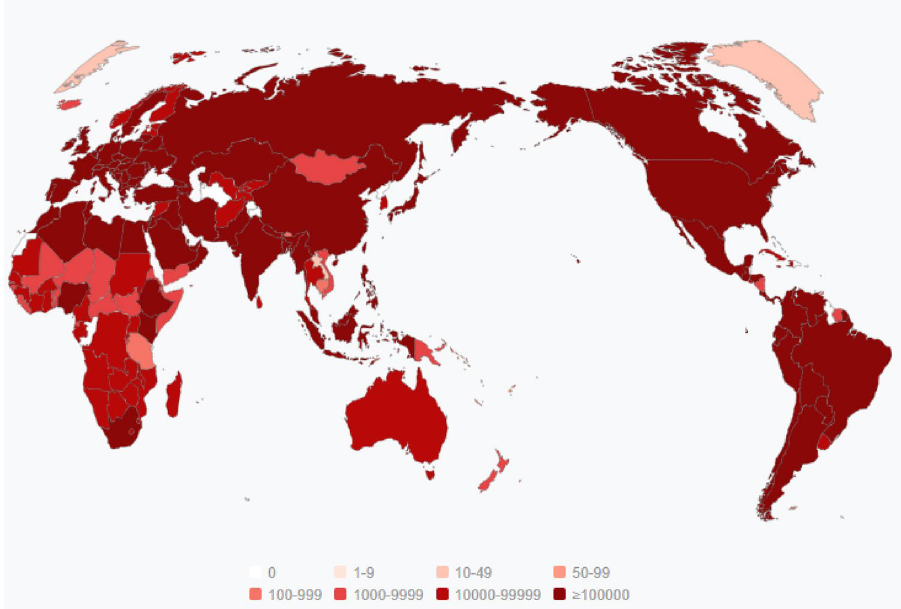
Figure 1. The number of people diagnosed in the world. The darker the color, the more infected people are (Map was from https:// geods. geogr aphy. wisc. edu/ covid 19/ physi cal- dista